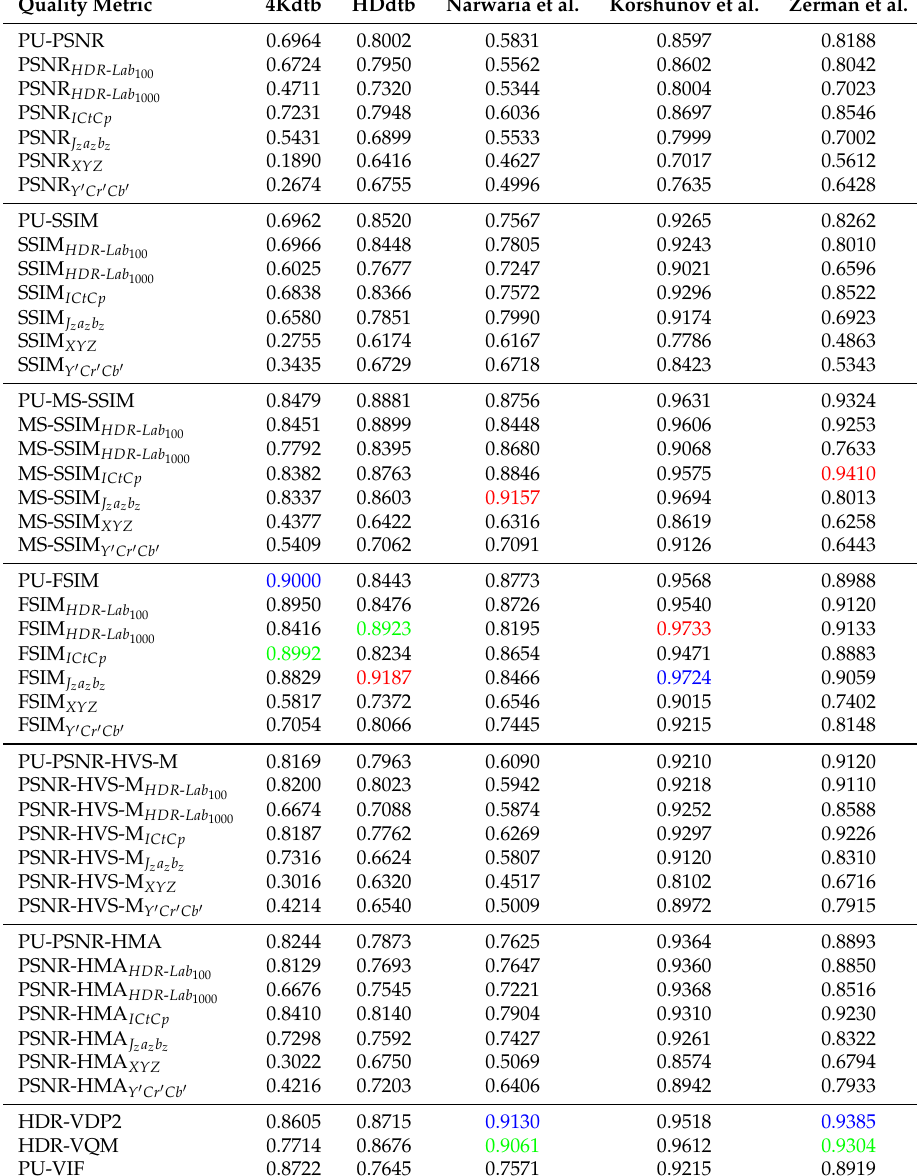
Table A1. PCC of the different color-blind quality metrics on the considered databases Quality